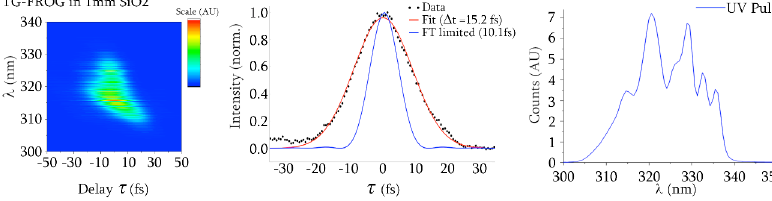
Figure 1: UV-pulse characterisation. Left: TG-FROG map. Middle: spectrally-average TG-FROG trace with its fit and the Fourier-transform limited pulse width. Right: UV pulse spectrum. We generate a sub-15fs UV pulse starting from a Yb-doped fiber amplifier delivering high-energy (100 uJ) NIR pulses at high and tuneable repetition rates up to 2MHz. A 6-fs red-NIR pulse is produced with a Non-collinear Optical Parametric Amplifier (NOPA) pumped with the second harmonic of the fiber amplifier as previously described [6]. We adapt the Achromatic Sum-Frequency Generation (ASFG) scheme proposed by Nabekawa et al. [7] to convert a large fraction of this Red-NIR spectrum into the 300-345 nm